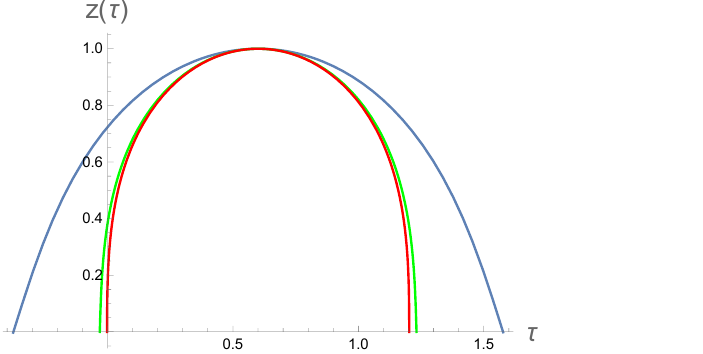
Figure 9 . Blue, green, red one represents the profile of EOW brane for T = − 1 / 3 , − 1 / 30 , − 1 / 300 respectively. In this plot we set z 0 = 1